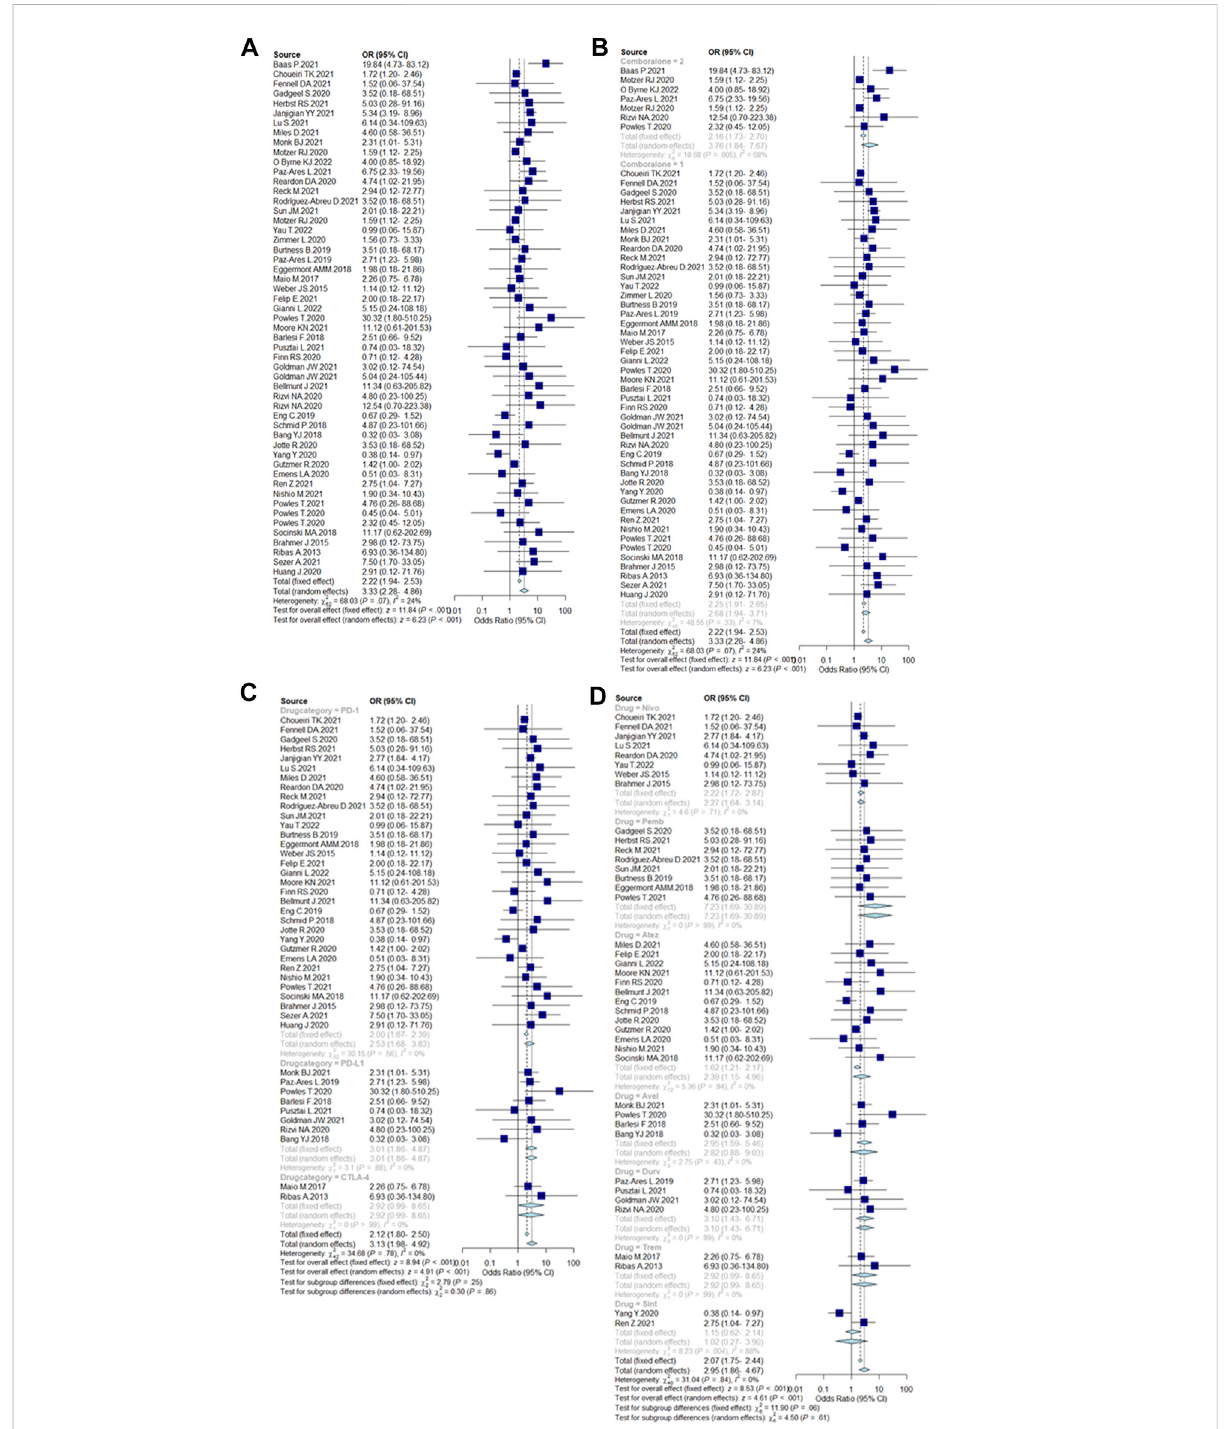
FIGURE 2 (A) Incidence of pancreatic injury caused by ICIs. Incidence rates are represented by boxes and whiskers represent 95% CIs. (B) Incidence of pancreatic injury caused by single ICIs or incombination, 2 = dual-ICIs, and 1 = single ICI. (C) Incidence of pancreatic injury caused by different drug categories of ICIs. (D) Incidence of pancreatic injury caused by various ICI